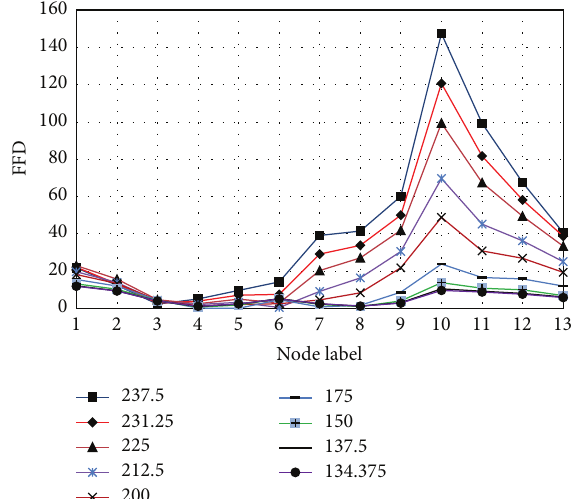
Figure 10: FFD distribution subjected to different stress ranges.